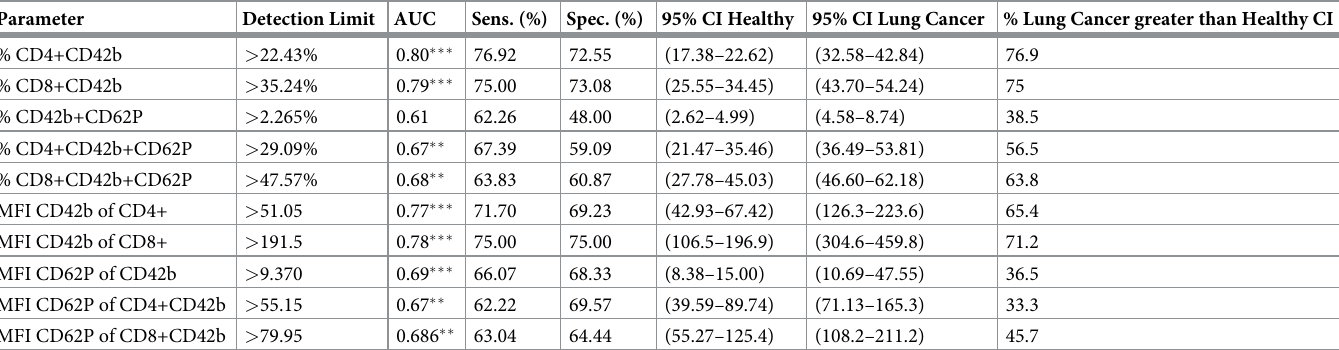
ROC curves were generated and area under the curve (AUC) was calculated with respective p-values. AUC curves were used to identify optimum sensitivity (Sens) and specificity (Spec). 95% confidence intervals for lung cancer patients and healthy volunteers. Confidence intervals calculated using GraphPad Prism. The percentage of lung cancer patients that fell outside of the healthy confidence interval was determined for each parameter. �� p � 0.01 ��� p �